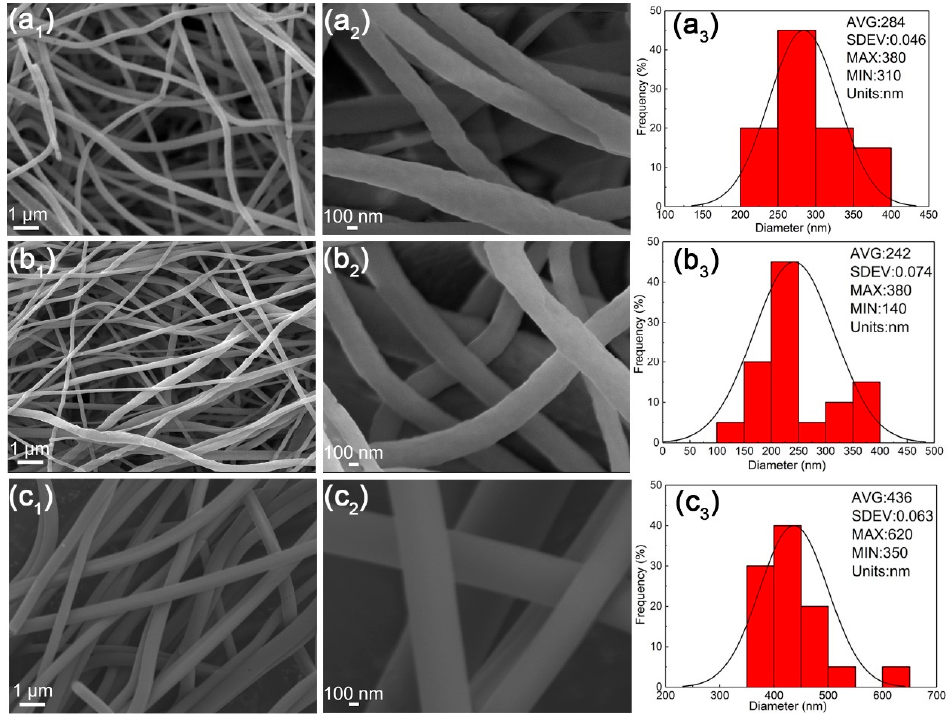
Figure 9. Representative SEM images of ( a1 – a2 ) oPAN, ( b1 – b2 ) oP(AN-co-IA), and ( c1 – c2 ) oP(AN-co-AMPS) nanofibers with different scales. ( a3 ), ( b3 ), and ( c3 ) are diameter distribution histograms corresponding to oPAN, oP(AN-co-IA), and oP(AN-co-AMPS) nanofibers, respectively. Polymers 2019 , 11 , x FOR PEER REVIEW